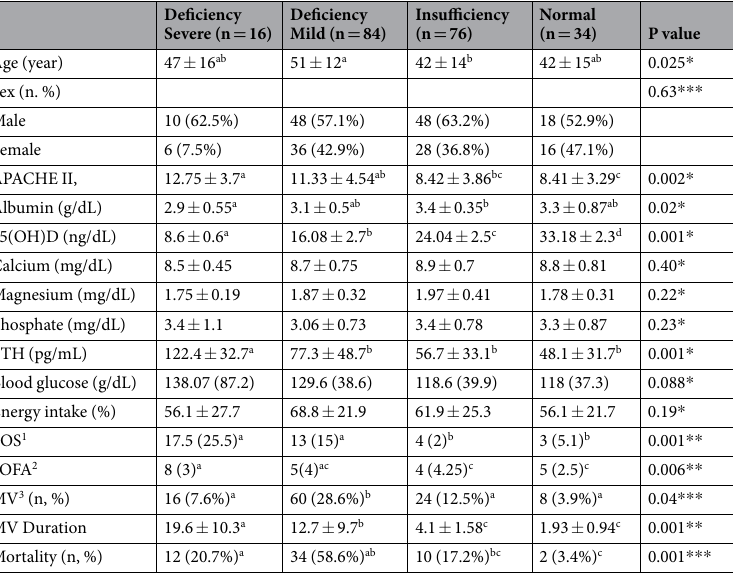
Table 1. Characteristics of patients based on 25-hydroxyvitamin D categorized groups. * One-way ANOVA (mean ± SD), ** Man-Whitney (median, IQ), *** Chi square. 1 Length of stay, 2 Sequentional organ failure assessment, 3 Mechanical ventilation. Values with different superscript letters are significantly